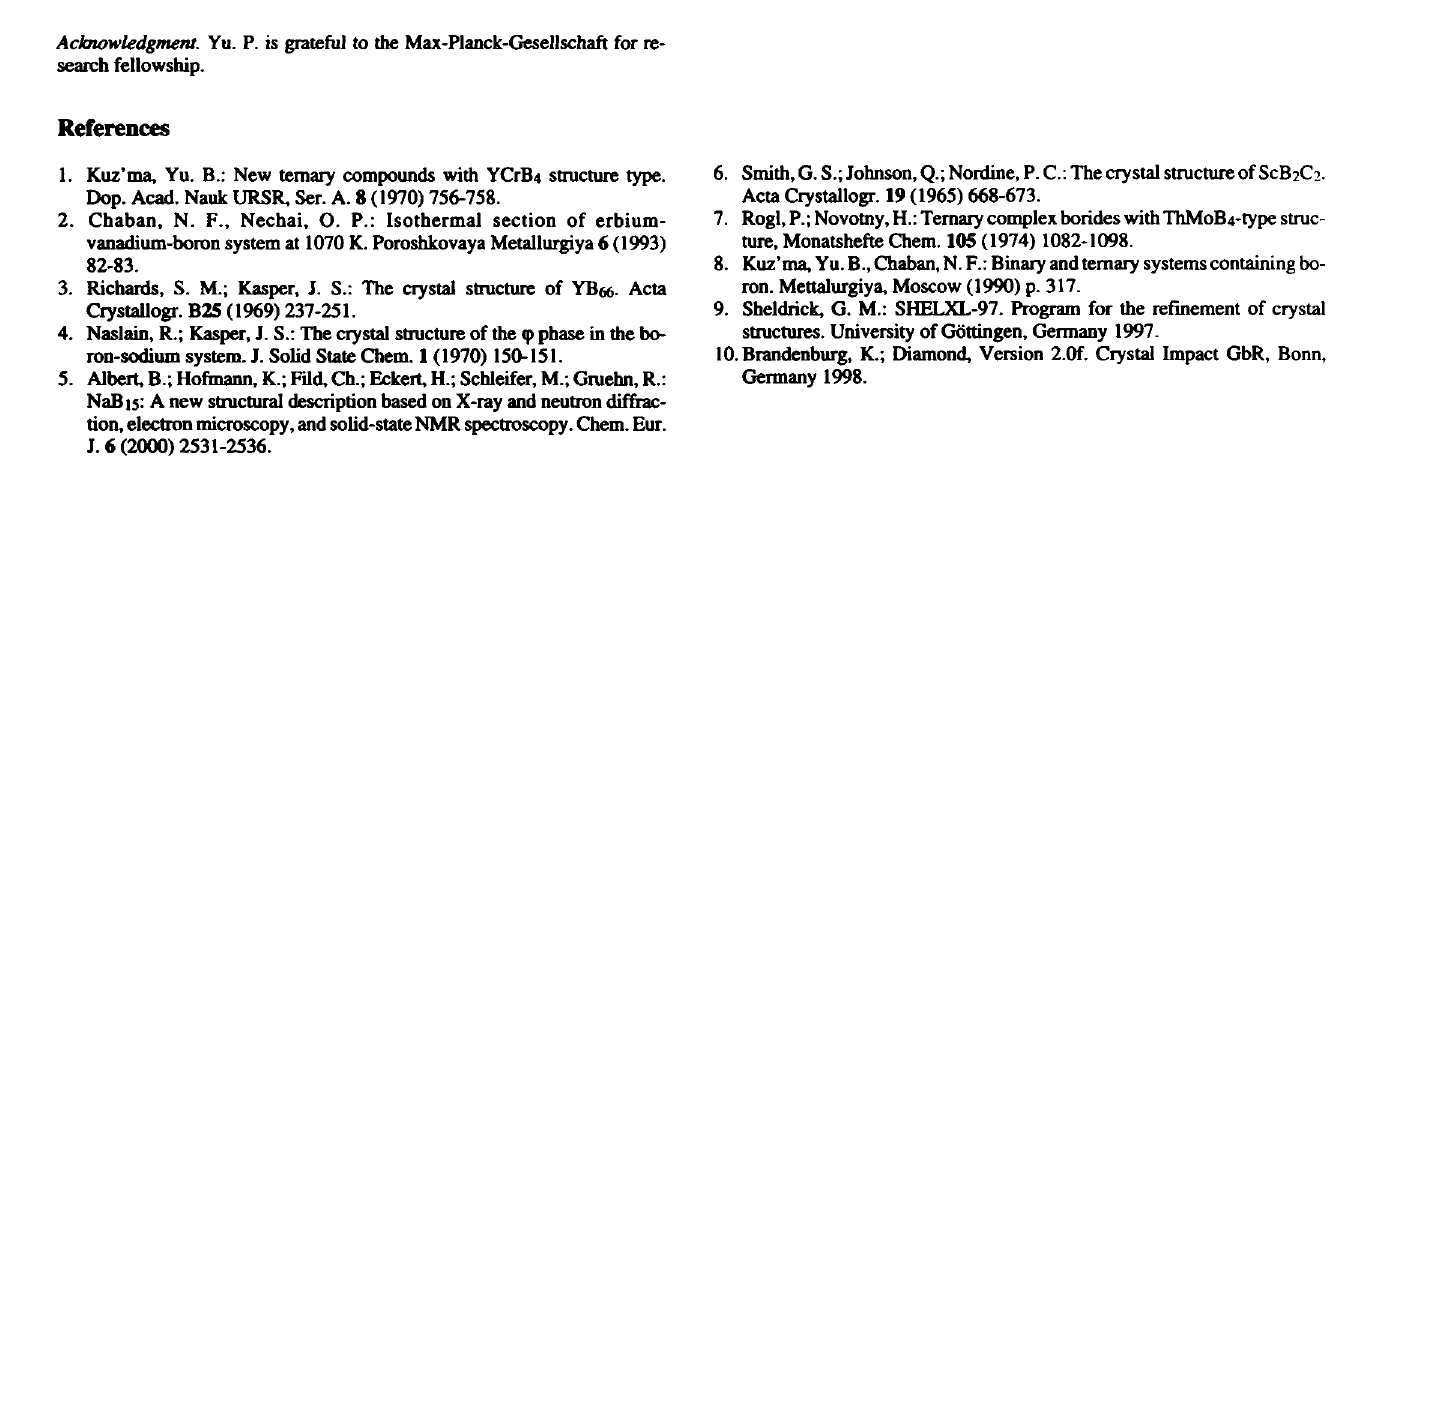
Table 3. Atomic coordinates and displacement parameters (in Á 2